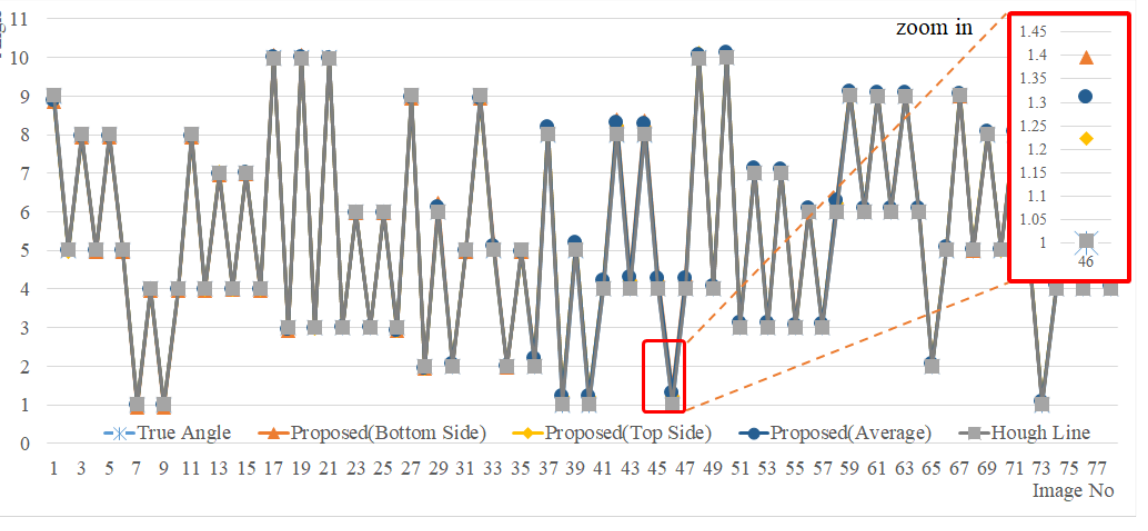
Figure 22. Angle measurement results. Table 2. Slope error